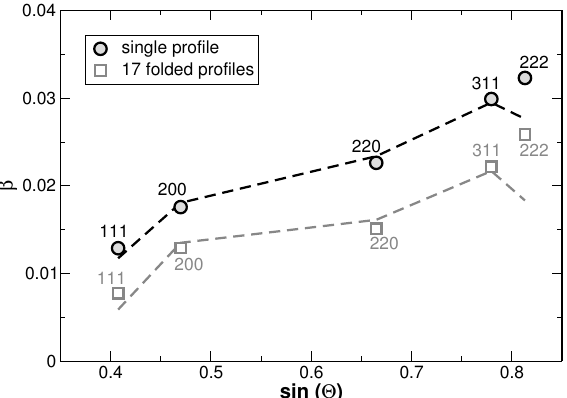
Figure A7. Alternative view of the Williamson-Hall analysis shown in Figure 9, pronouncing the elastic anisotropy of the XRD line broadening. The dashed lines represent fits to the line broadening including the cubic invariant according to References